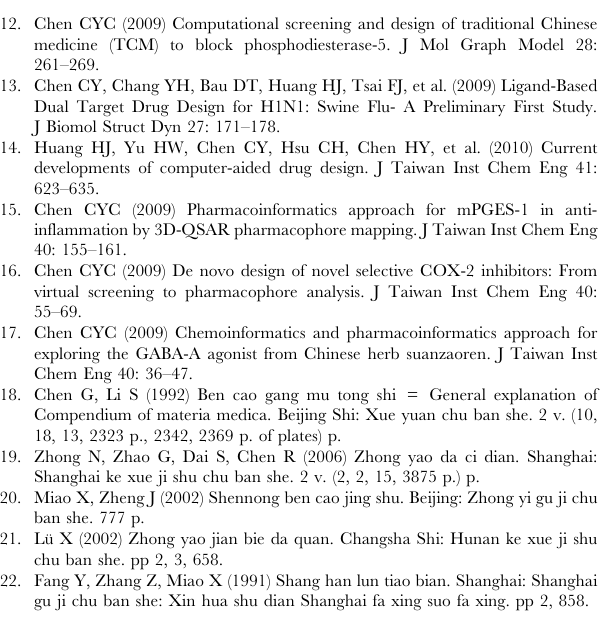
Figure 4. The infrastructure of the TCM database. The design is adapted from Norbert Haider’s